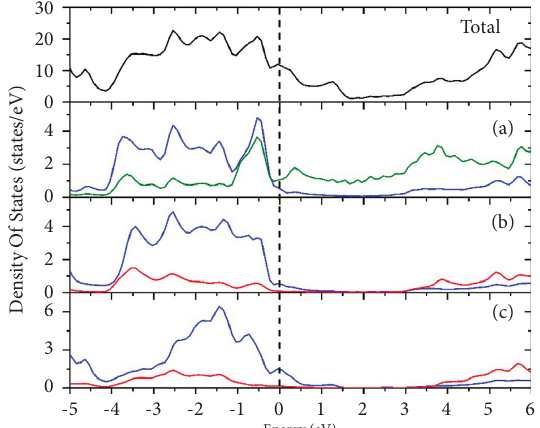
Figure 9: DOS and PDOS for a bilayer GeC. The contribution of Ga-p (red lines), N-p (blue lines), Ge-p (olive lines), and C-p (wine lines) is